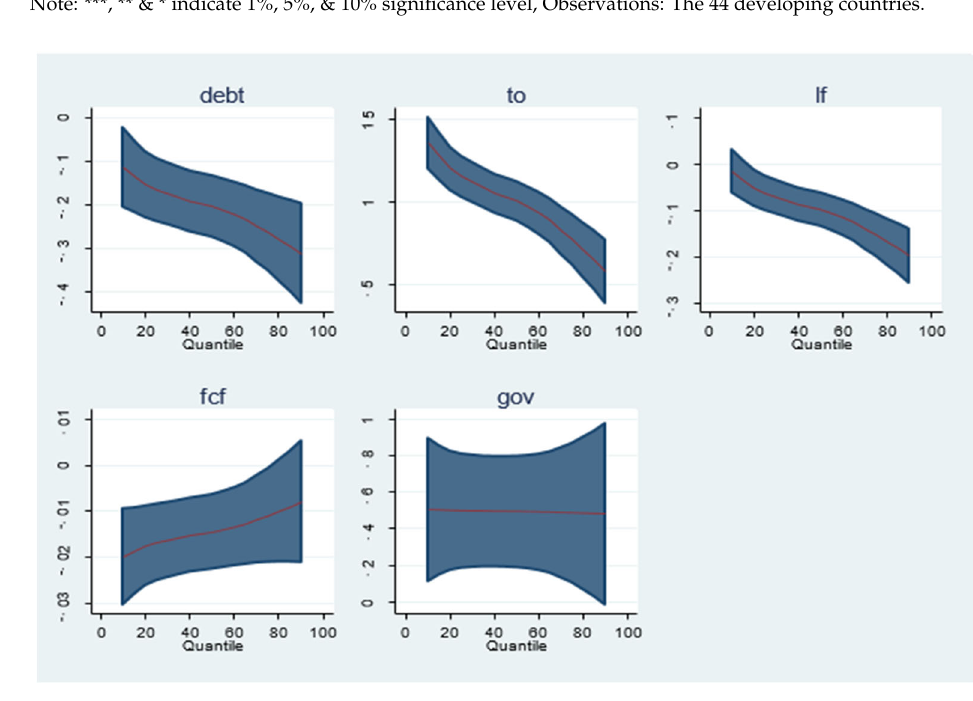
Table 4. Impact of governance on growth under different quantiles.